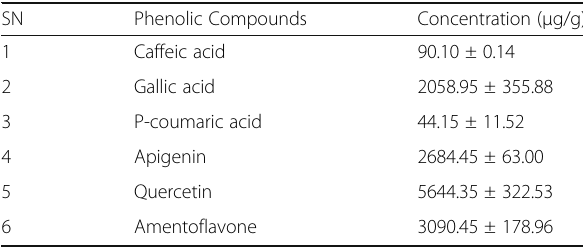
Table 7 The concentration of some phenolic antioxidants detected in the ethanol extract of Nigella sativa